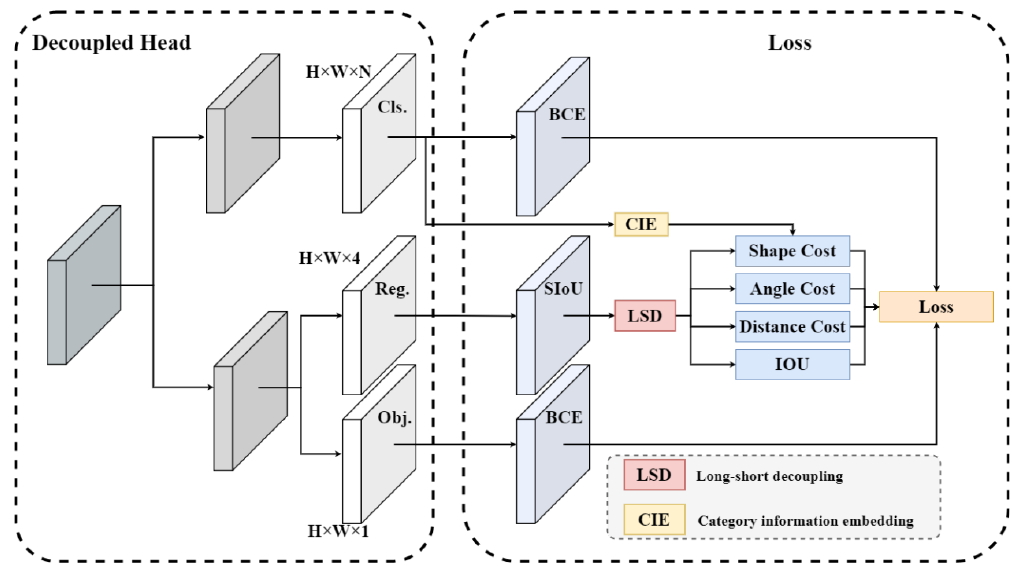
Figure 7. SD-SIoU structure diagram.